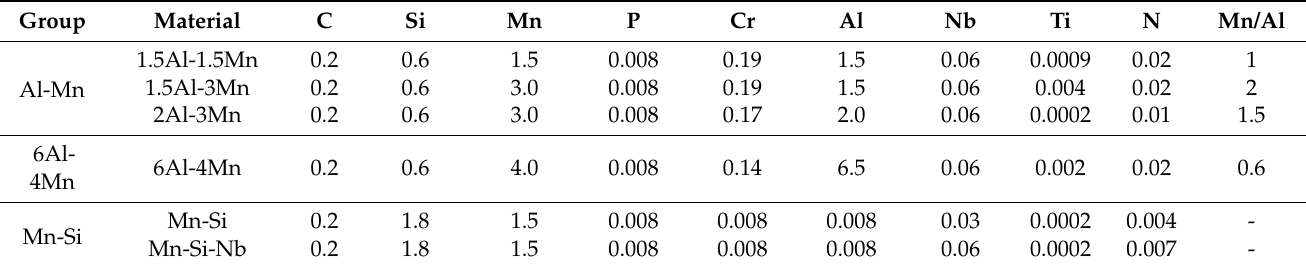
Table 1. Chemical composition of experimental steels in wt.%.